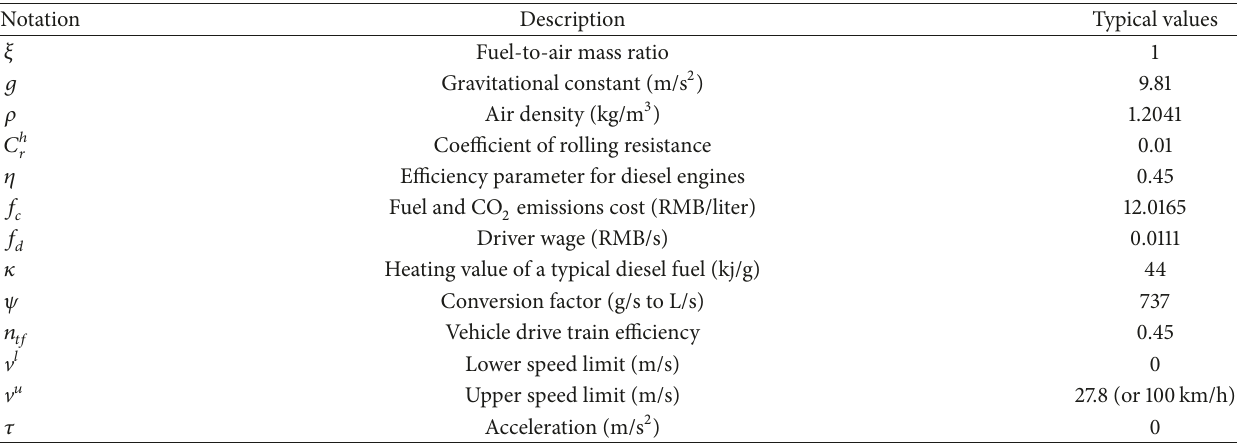
Table 1: Common parameters of vehicles.